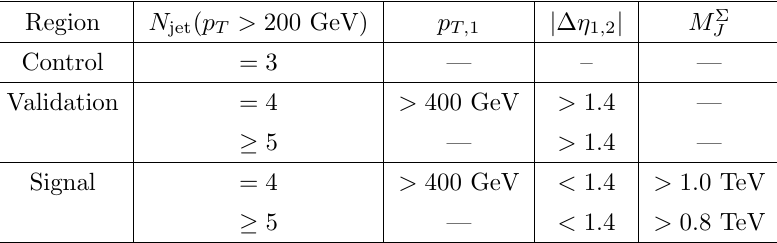
Table 1 . Phasespace requirements for the di(cid:11)erent regions